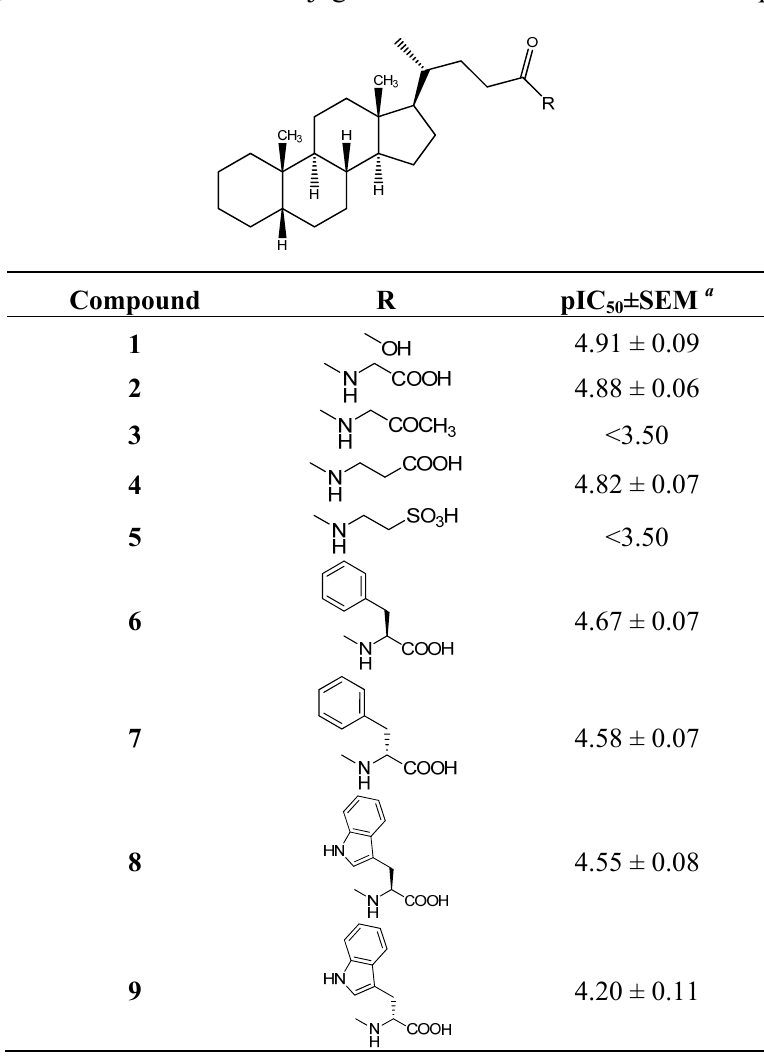
Table 1. pIC values for amino acid conjugates of cholanic acid tested on the EphA2 50